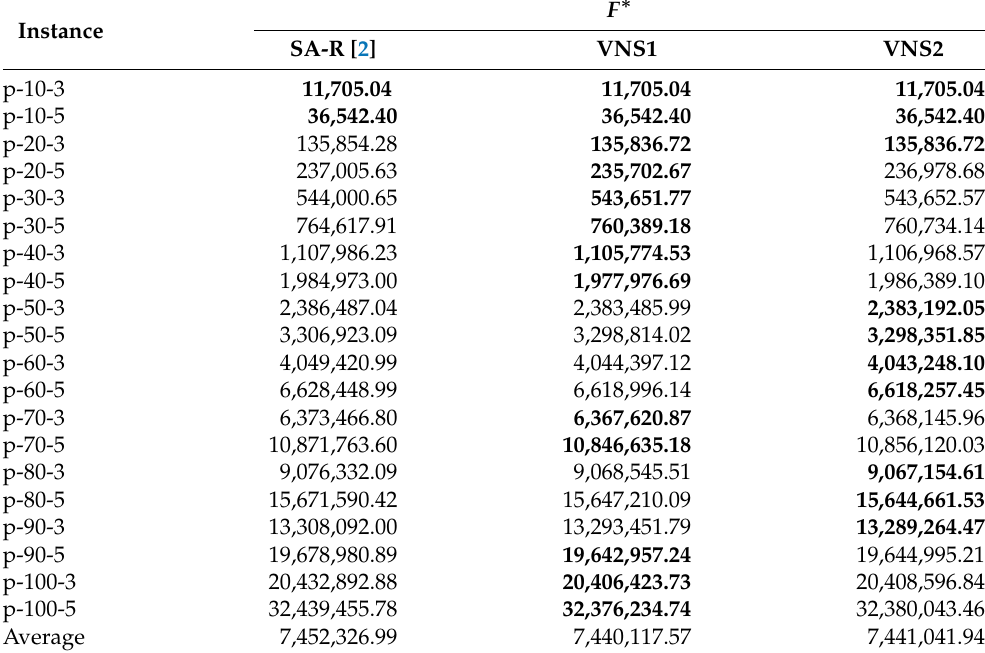
Table 2. Best results of VNS1, VNS2, and SA-R for smaller sized